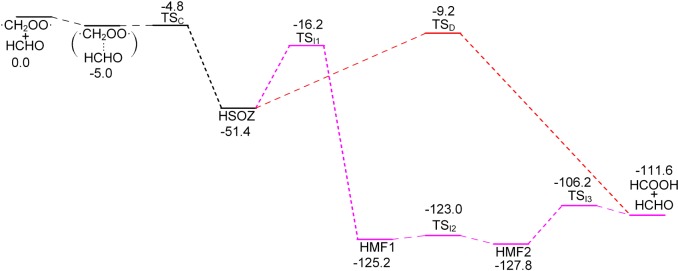
Potential energy surface (kcal mol−1) of the ·CH2OO· + HCHO reaction calculated at the CBS-QB3 level.